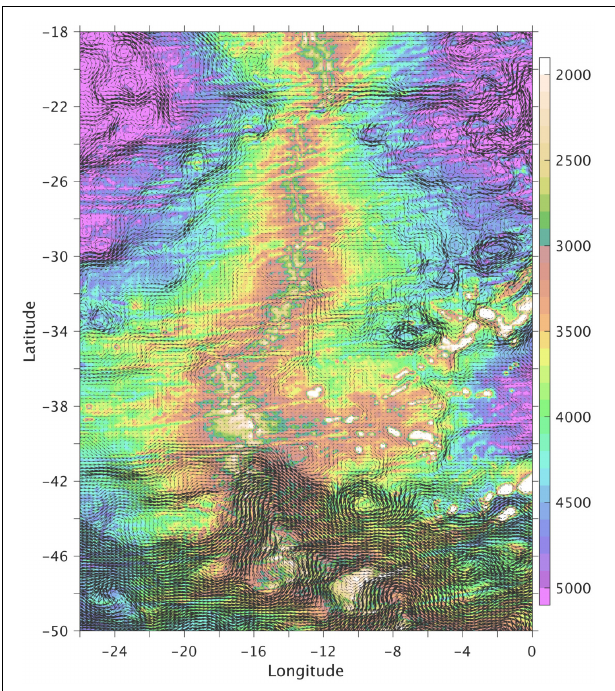
FIGURE 15 | Zoomed view of the modeled mean circulation for the density layer of NADW (36.58 < σ 2 < 37.12 kg m − 3 ) across the Mid-Atlantic Ridge in the South Atlantic